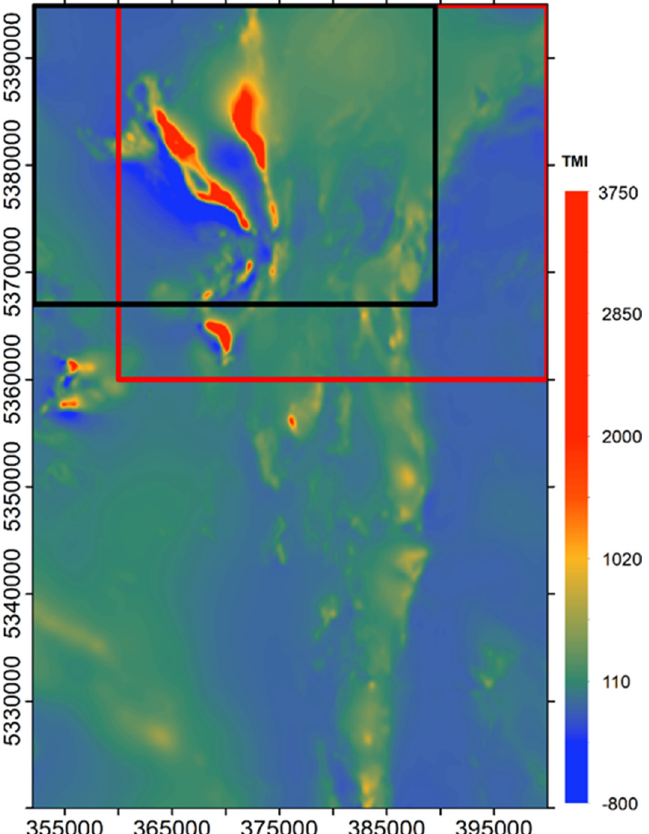
Figure 6. The observed total magnetic intensity (TMI, nT) highlighting the response of the various lithologies that contribute to the local magnetic field. D model extents. Features exhibiting the highest magnetic responses are associated with allochthonous fault-bounded slices of serpentinized ultramafic material (“ultramafic complexes”). The x- and y-axes are measured in meters east and north, respectively. These measurements apply to all subsequent grid images.